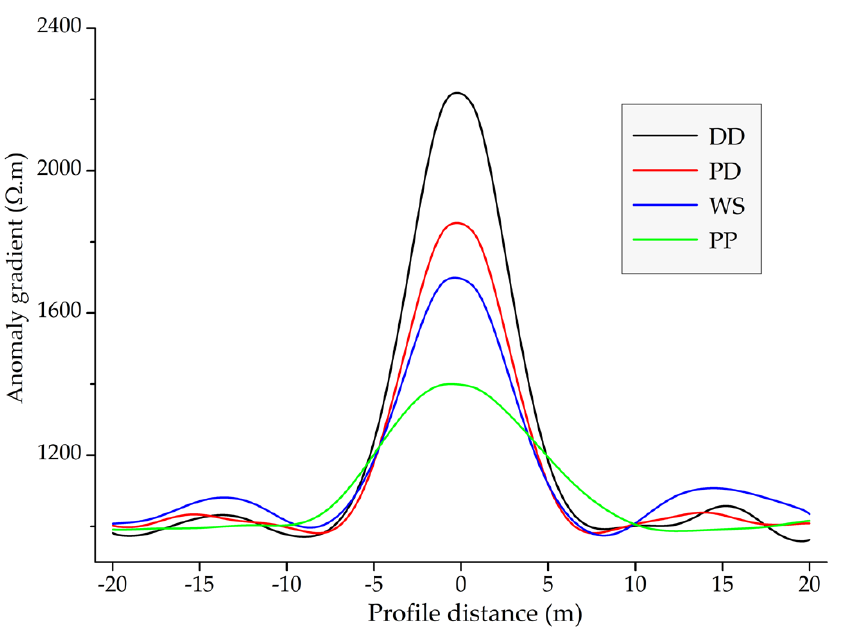
Figure 11. Resistivity anomaly gradient of the arrays for the target cavity T 2 .